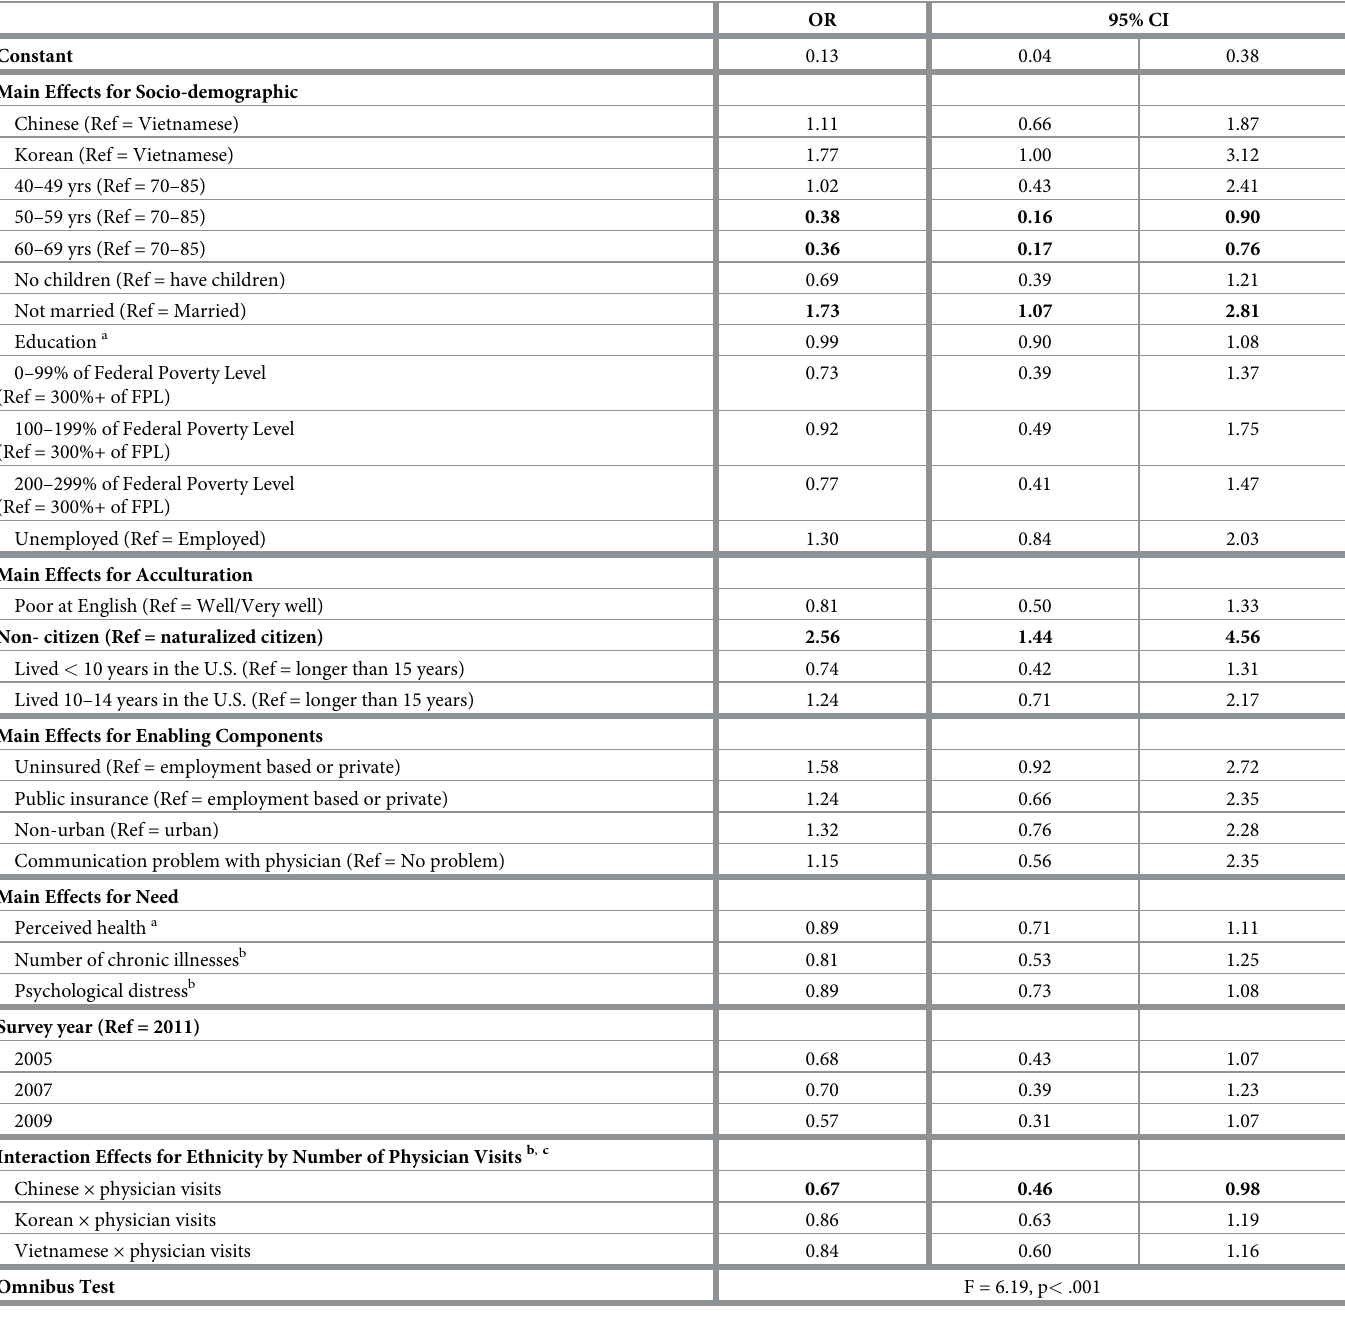
Table 4. Final trimmed multivariate logistic regression with significant interaction effects by ethnicity (unweighted N = 3,710; weighted N =